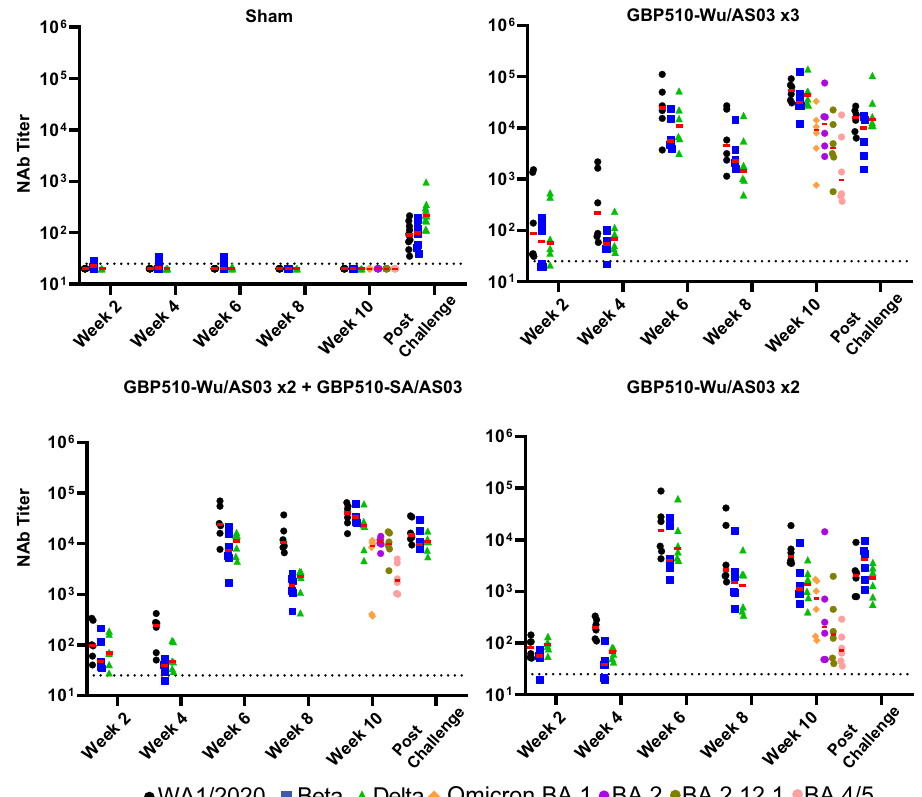
Fig. 2 Neutralizing antibody responses measured to the vaccines. Neutralizing antibody (NAb) titers by luciferase-based pseudovirus neutralization assay for WA1/2020 (black circles), Beta (blue squares), and Delta (green triangles) matched pseudoviruses. The limit of quantitation (NT50 = 20) is represented by a dotted line. Medians are shown with red bars. Group 1 received three sham doses, Group 2 received three doses of GBP510-Wu, Group 3 received two doses of GBP510-Wu and one dose of GBP510-SA, and Group 4 received two doses of GBH510-Wu and one sham